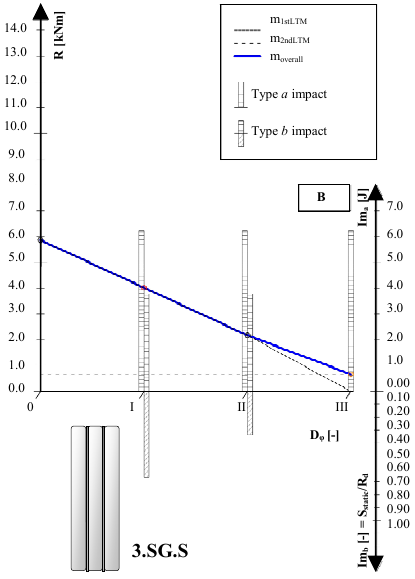
Figure 13: Element Safety Diagram for triple layer, SG-laminated, heat strengthened glass beam.